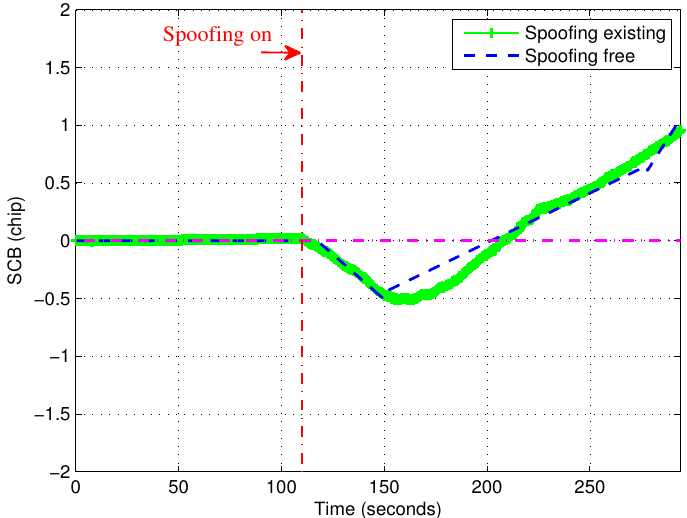
Figure 5. Experimental and the theoretical SCB curves for PRN